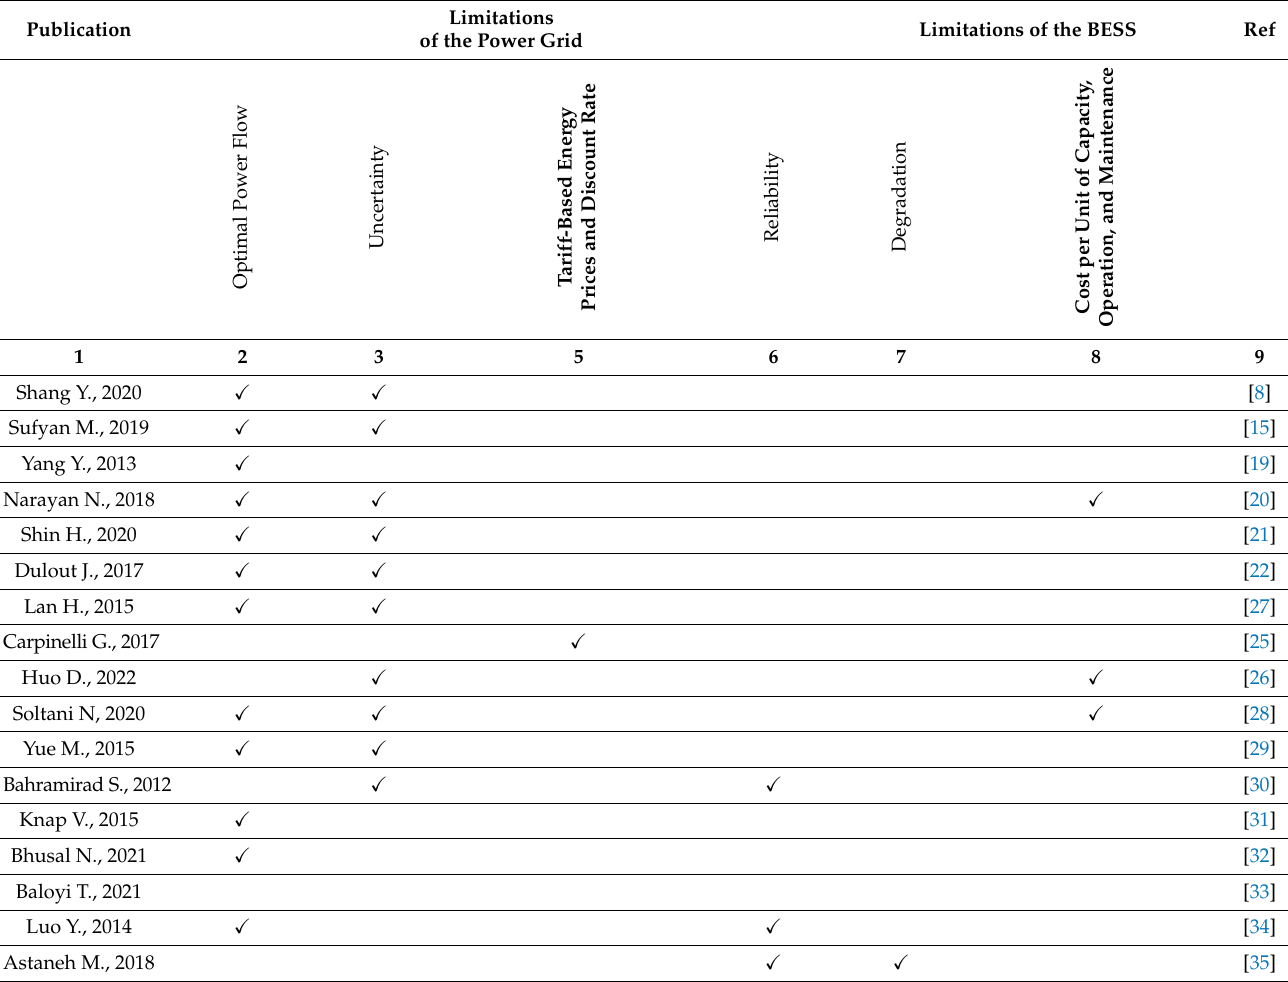
Table 1. Input quantities for optimal sizing of a battery in the microgrid